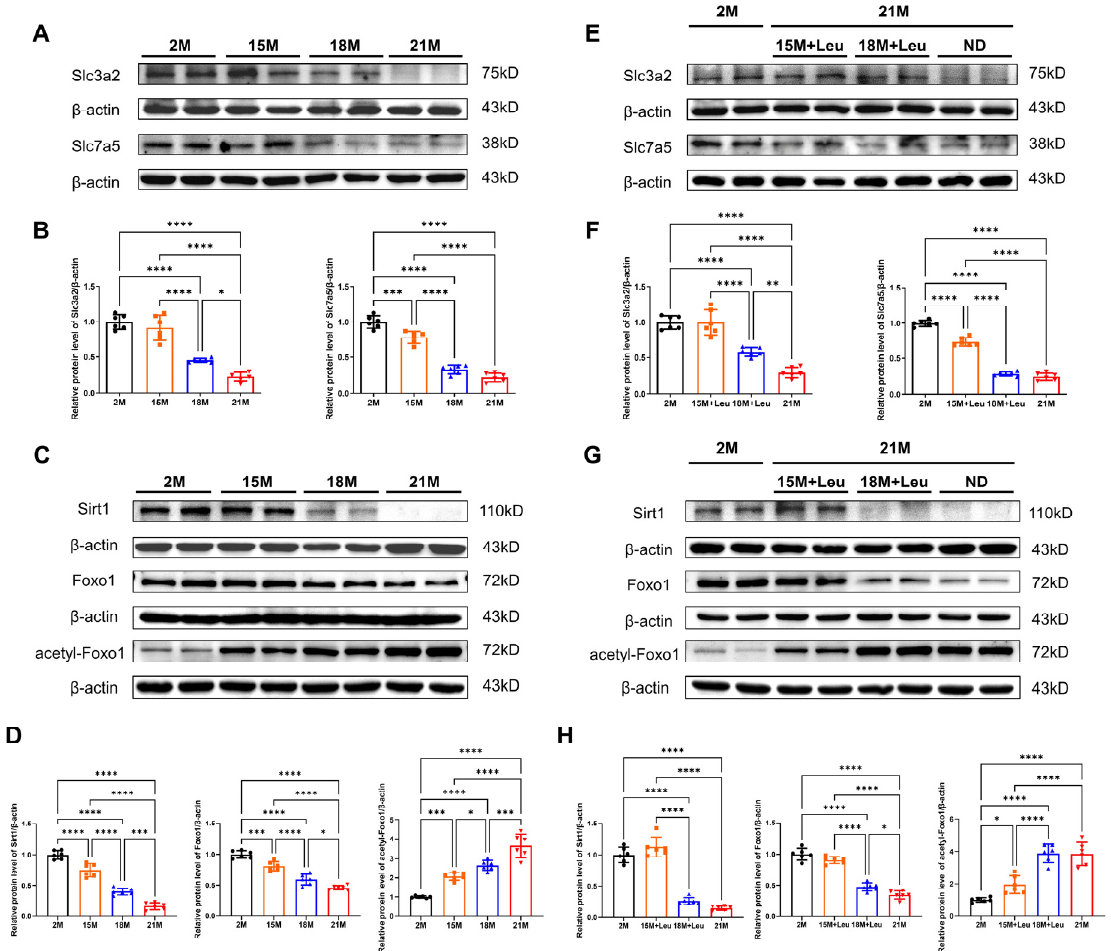
Figure 4. Leucine protected against aging-induced vascular damage via Sirt1–Foxo1 pathway. Representative Western blot and quantification of vascular leucine transporters Slc3a2 and Slc7a5 from mice at different ages are in ( A , B ). Representative Western blot and quantification of Sirt1, Foxo1, and acetyl-Foxo1 from mice at different ages are shown in ( C , D ). Representative Western blot and quantification of vascular Slc3a2 and Slc7a5 from mice in different intervention groups are shown in ( E , F ). Representative Western blot and quantification of Sirt1, Foxo1, and acetyl-Foxo1 from mice in different intervention groups are shown in ( G , H ). Statistical analysis was performed using one-way ANOVA; data are presented as mean ± SEM, n = 6/group. * p < 0.05, ** p < 0.01, *** p < 0.001, and **** p < 0.0001. ND: Normal diet.